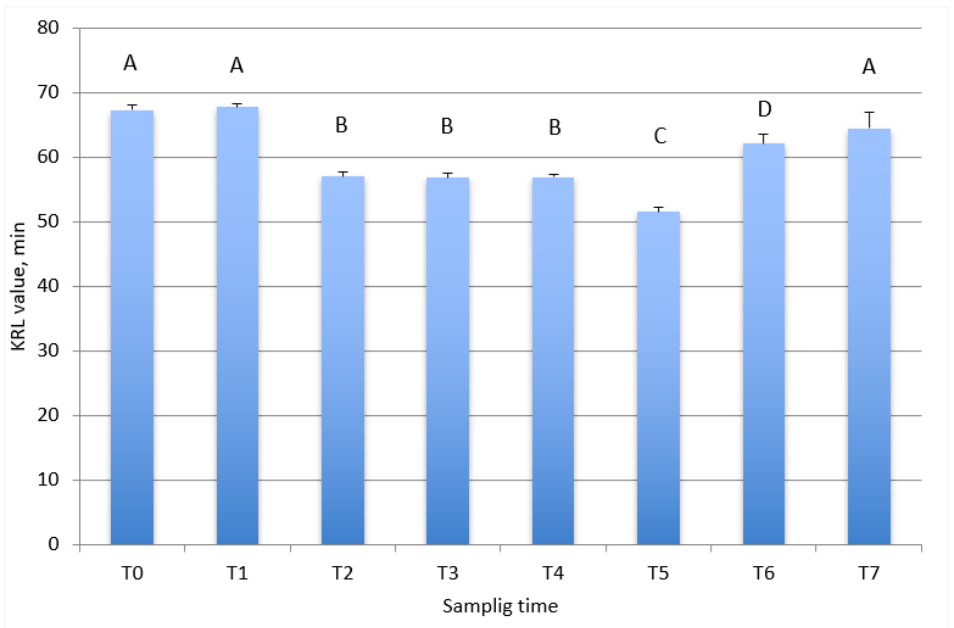
Figure 2. Total antiradicalic activity of red blood cells in relation to the training program of the trotter horses. Data are reported as mean ± SEM. T0, start of taming period; T1, 60 days from start of taming period; T2, beginning of training period; T3, 60 days after the start of training period; T4, 120 days after the start of training period; T5,180 days after the start of training period; T6, beginning of racing season; T7, 60 days after the beginning of racing season. A, B, C, D differs for p < 0.001. Table 2. Haematological parameters of trotter horses in relation to the training program. Sampling Item